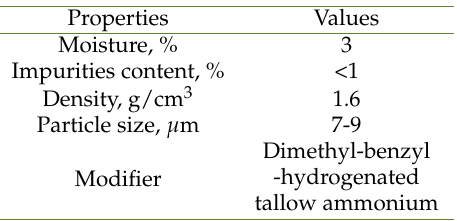
Table 2. Nanoclay Dellite 43B physical properties